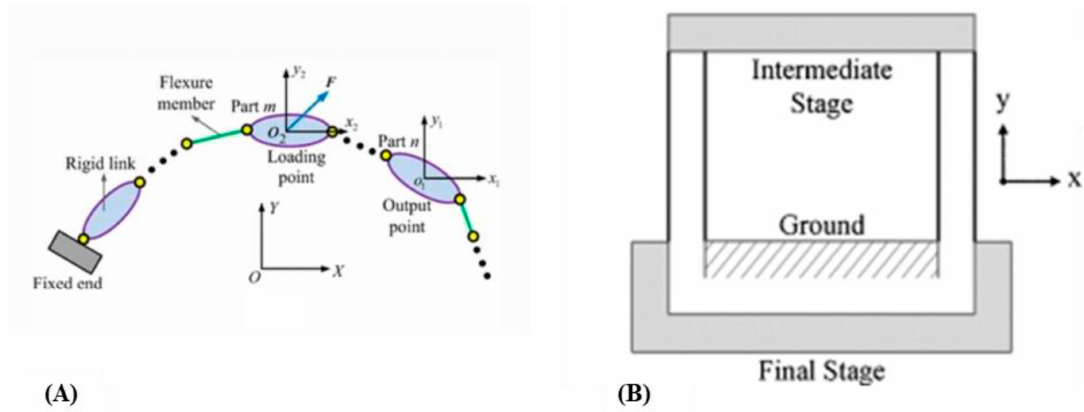
Figure 5. ( A ) Serial CM [48]; ( B ) Parallel CM-based parallelogram flexure unit